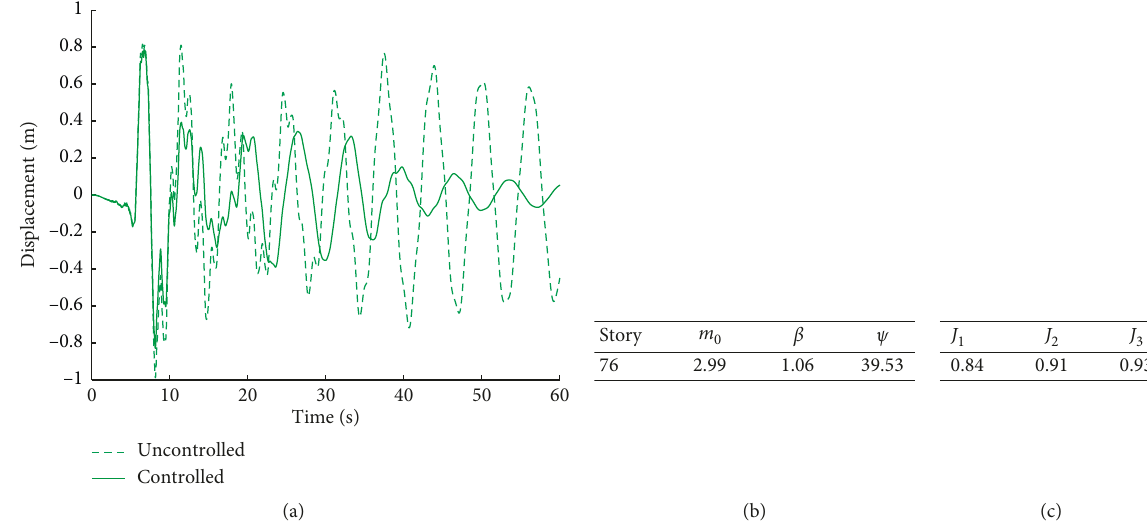
Figure 12: Uncontrolled/controlled responses under the El Centro earthquake. (a) Roof displacement response. (b) TMD specifications. (c) Objective values.